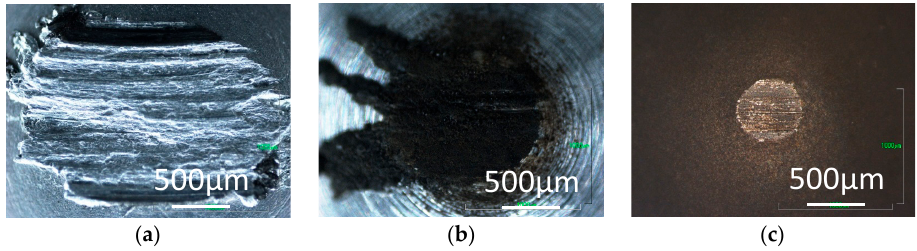
Figure 4. Photographs of aluminum pins slid against a-C:H DLC in nitrogen; with ( a ) 0 ppm water; ( b ) 60 ppm water; and ( c ) 120 ppm water.